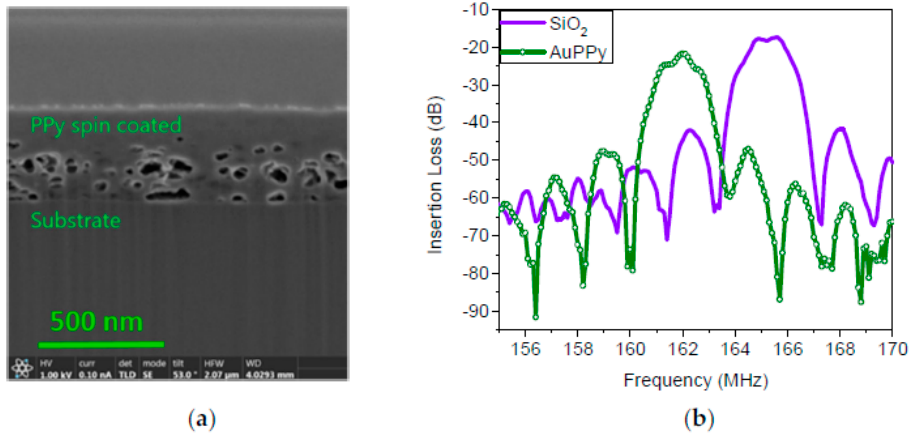
Figure 2. ( a ) Cross-sectional SEM image of the spin-coated PPy NPs; ( b ) Comparison of the amplitude of transmission parameter S 21 of the LW sensors with the first guiding layer (SiO 2 ) and multiguiding layer (SiO 2 + AuPPy NPs).